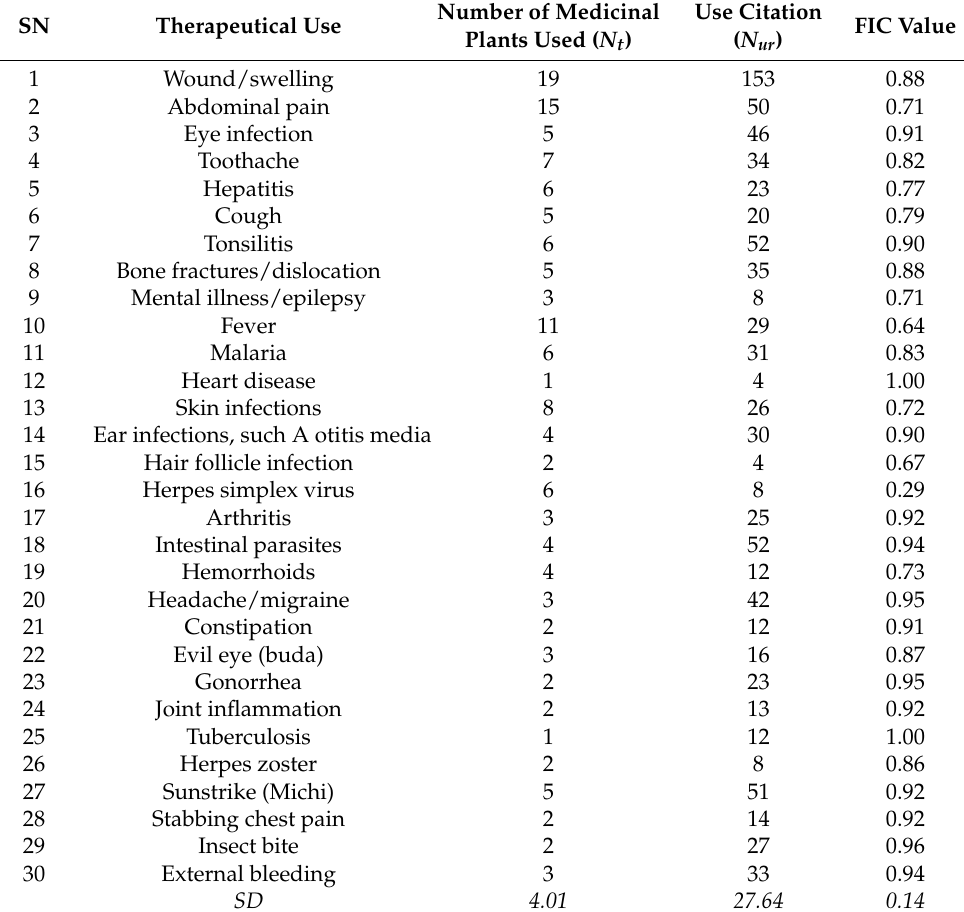
Table 3. FIC values of the therapeutical uses of medicinal plants.